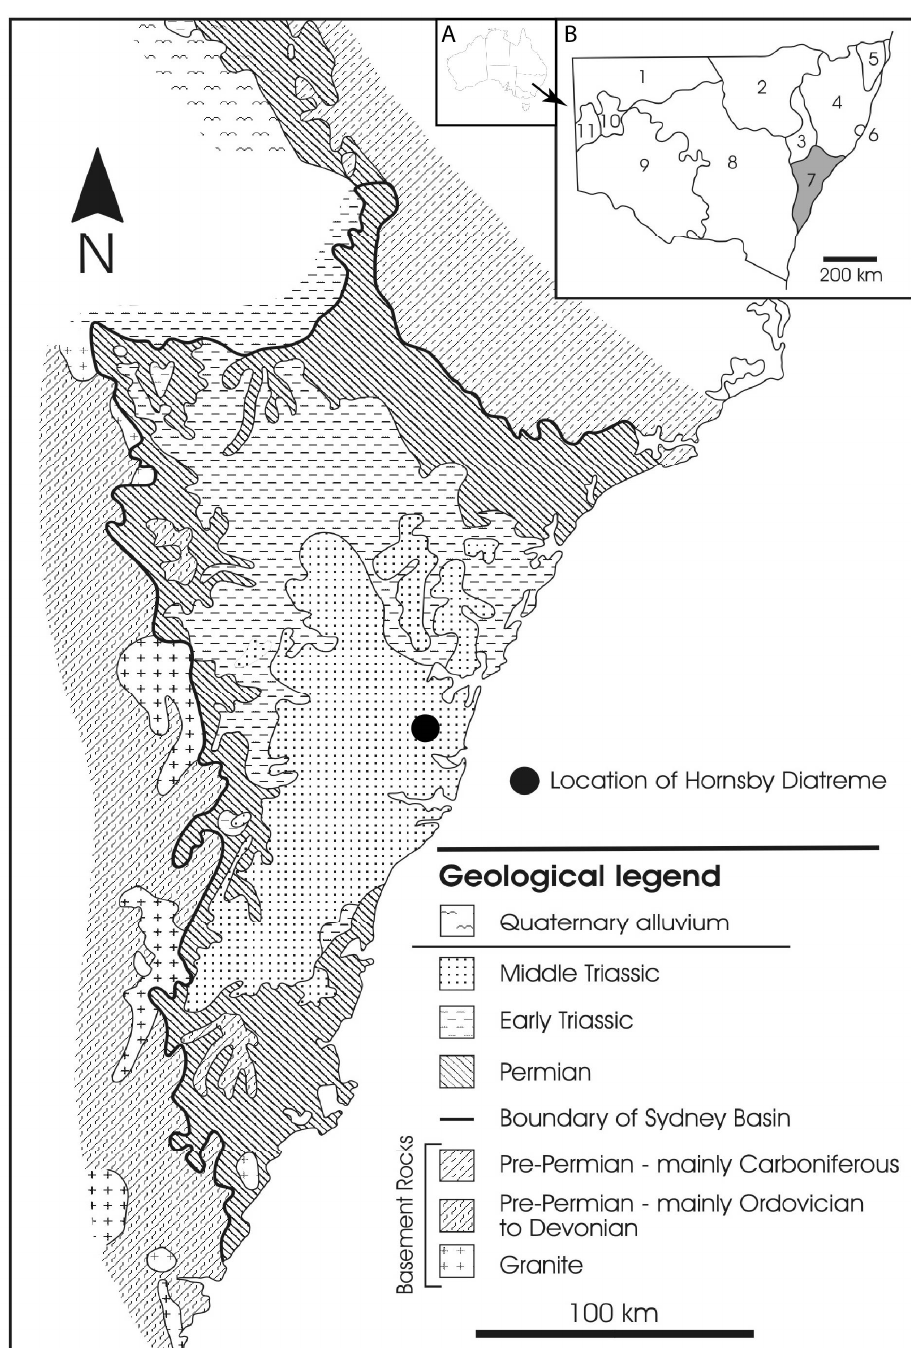
Figure 1. The geology of the Sydney Basin, and the location of the Hornsby Diatreme; A: This inset shows the location of New South Wales (NSW) within Australia; B: This inset shows the location of the Sydney Basin (region 7) and other geological terranes within NSW, as described by Branagan and Packham [9,10].